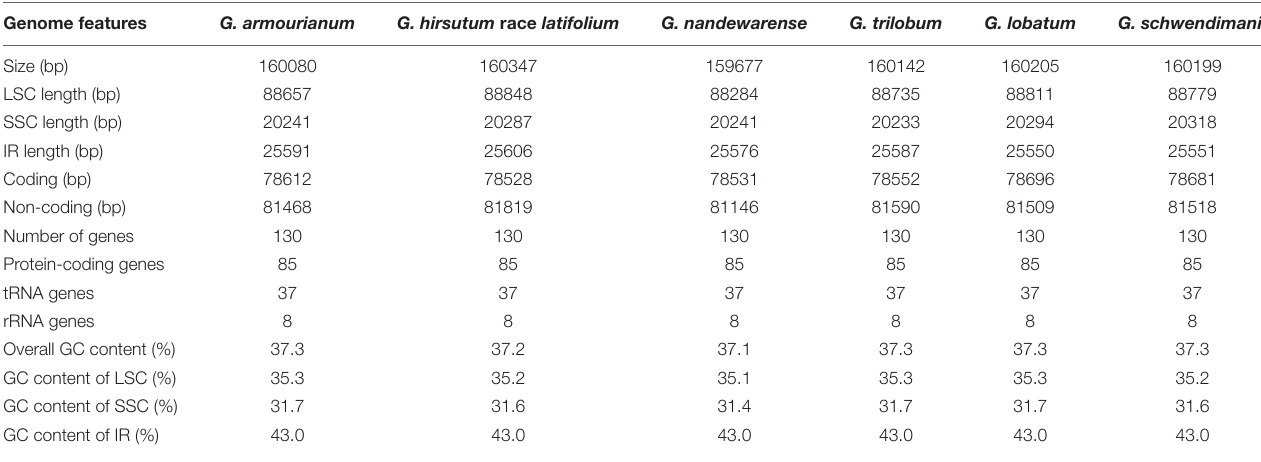
TABLE 1 | Characteristics of chloroplast genomes in six Gossypium species. Genome